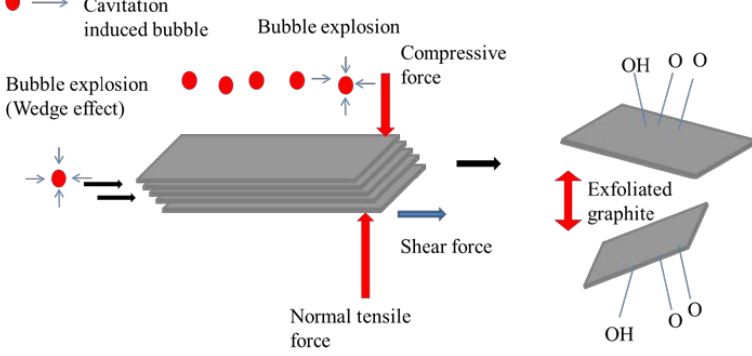
Figure 2. Illustration of the possible mechanism of graphite exfoliation.